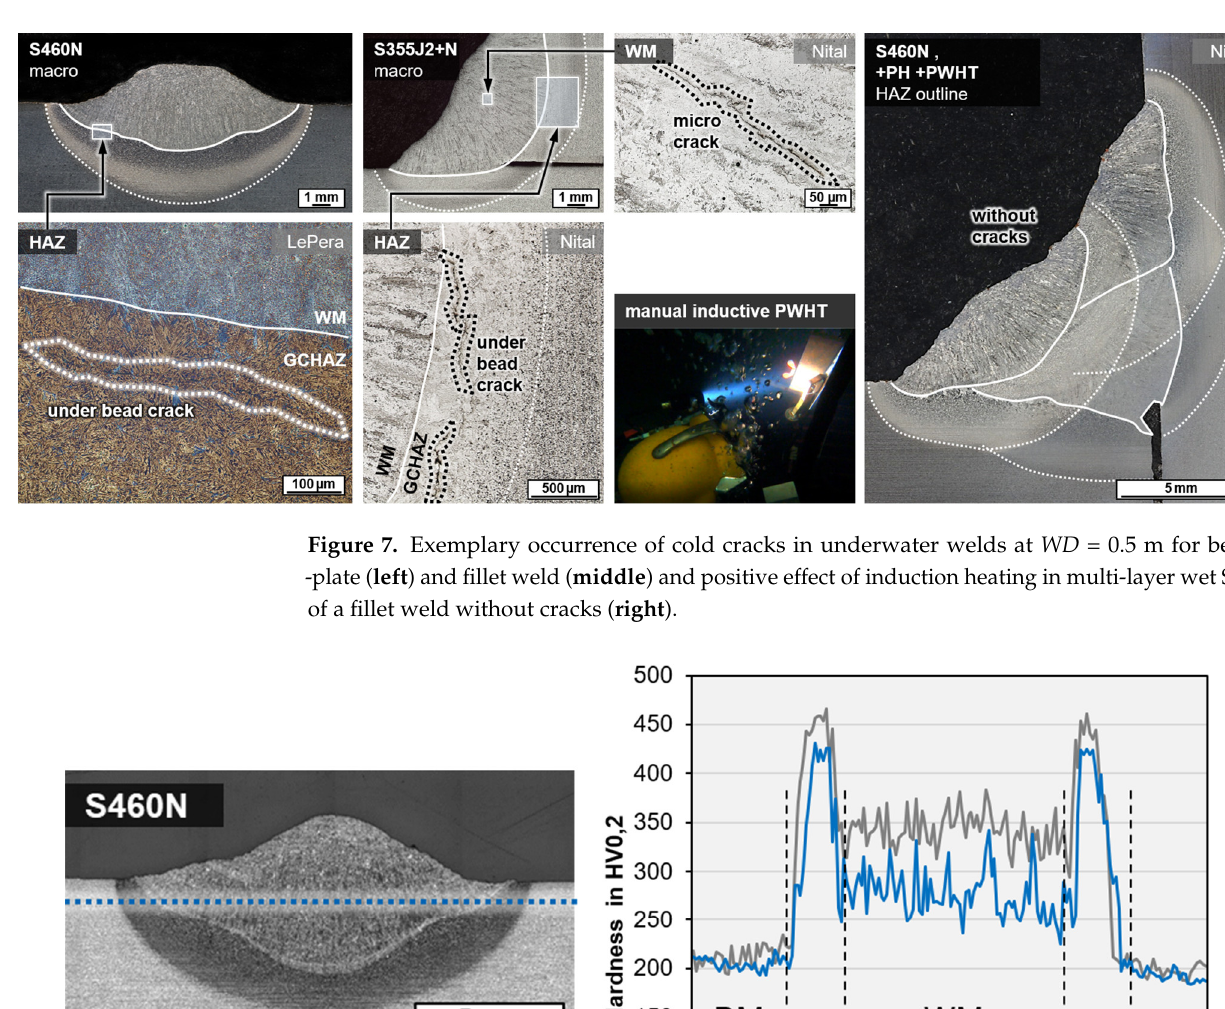
Table 4. Hardness values in specific regions of the bead-on-plate welds, references and with PH.